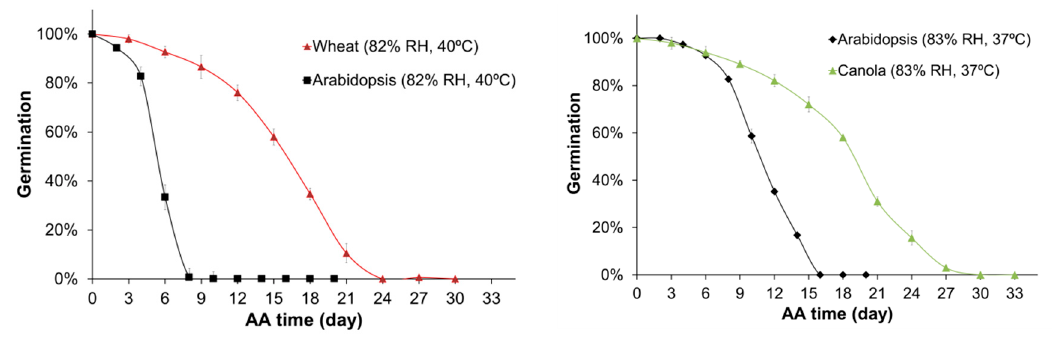
Figure 1. Seed germination kinetics of wheat, canola, and Arabidopsis seeds during an accelerated aging (AA) process. ( a ) Comparison between acceleratedly aged seeds of wheat and Arabidopsis under the AA conditions of 40 ° C and 82% relative humidity (RH). ( b ) Comparison between acceleratedly aged seeds of canola and Arabidopsis under the AA conditions of 37 ° C and 83% RH. For each AA seed lot, 50 seeds of wheat, or 100 seeds of canola, or 100 seeds of Arabidopsis were sterilized and rinsed in ddH 2 O before being plated on ½ Murashige and Skoog salts (MS) plate. Seed germination was evaluated after seven days of incubation. The germination percentages were calculated based on three replicates and the standard errors are shown.